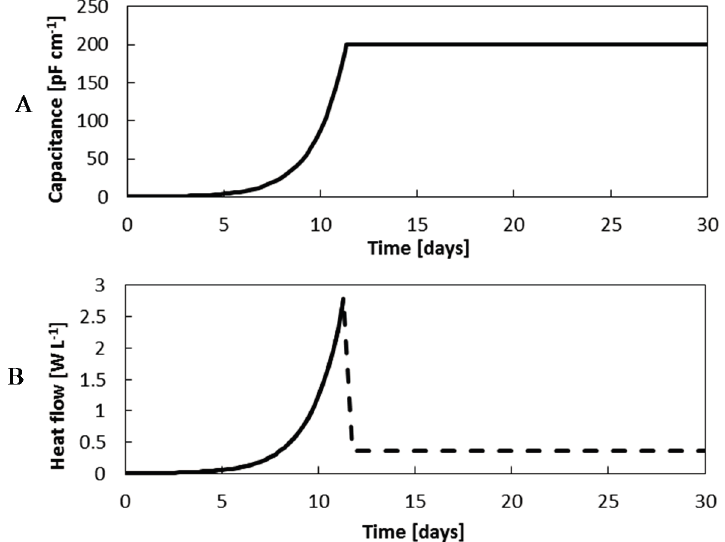
Figure 9. Capacitance ( A ) and heat flow ( B ) predictions throughout the exponential phase, assuming the cells duplicate at the maximum growth rate μ max = 0.64 day − 1 , and the stationary phase, when the full microcapsule colonisation potential has been